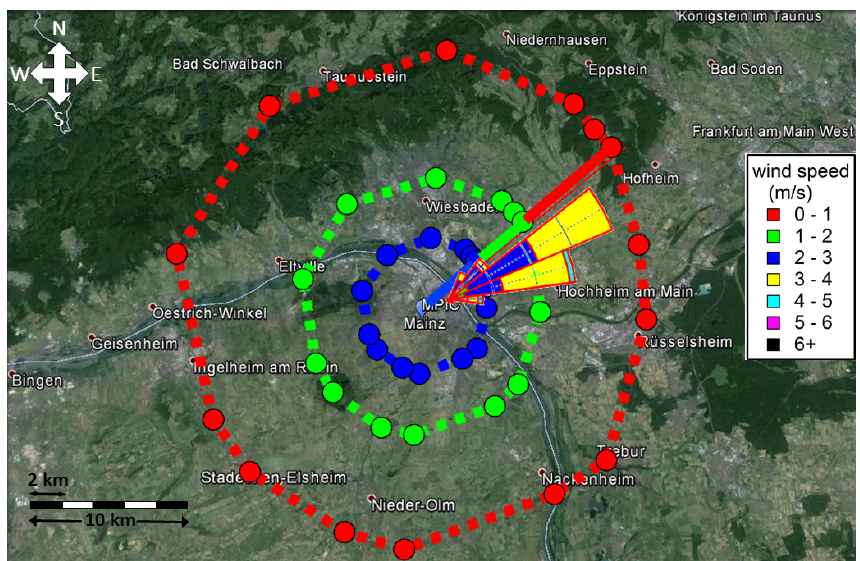
Figure 8. Map of the surroundings around the city of Mainz, Germany. The circles represent the MAX-DOAS spatial scales probed in different azimuth directions, and at different wavelengths: blue – the average L eff determined for the 2 ◦ EA at 350nm; green – 477nm; red – 577nm at noon on 17 June 2013. The solid line in azimuth direction of 50.8 represents the “standard” AA where the EA scans were performed. The diurnal azimuth distribution of wind speed is also